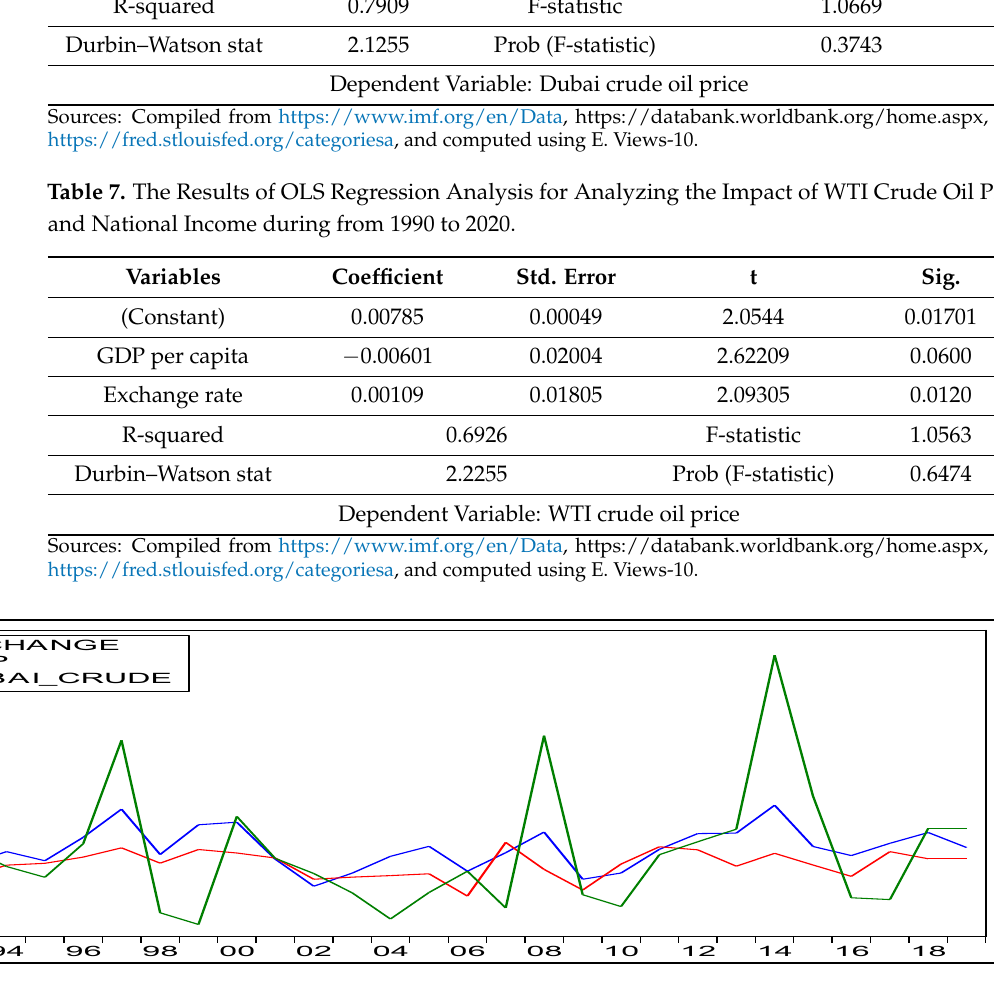
Figure 7. Graphical Expression for the Return Data of Exchange Rates of US dollar (US $)/Indian Rupee (INR), GDP per Capita and WTI Crude Oil Price in US dollar (US $) during 1990 to 2020; Sources: